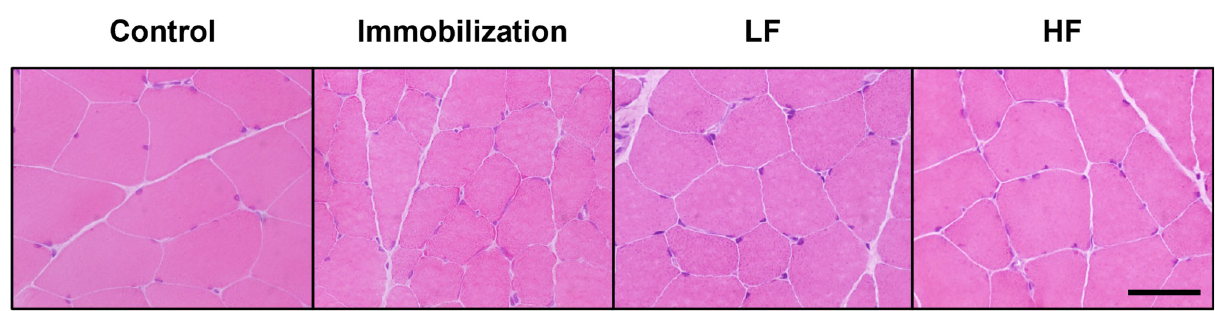
Fig 3. Hematoxylin and eosin-stained imaging of rat gastrocnemius muscles. No abnormal findings are visible in the experimental groups, except for atrophic changes. Scale bar, 50 μ m.